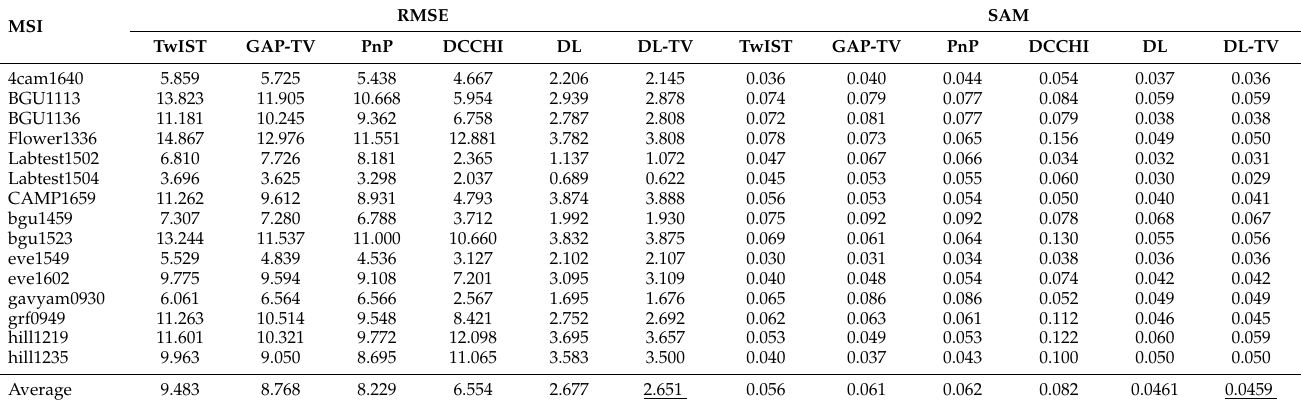
Table 4. Average RMSE and SAM of the 15 reconstructed MSIs for the ICVL dataset.